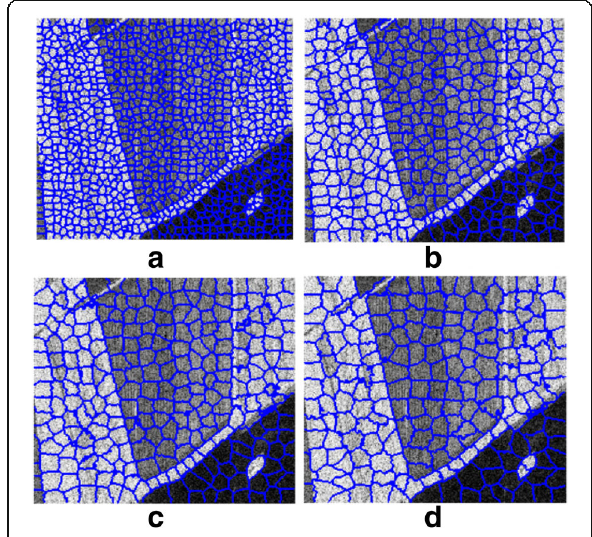
Fig. 6 The superpixels generated with different parameters. a a = 7,